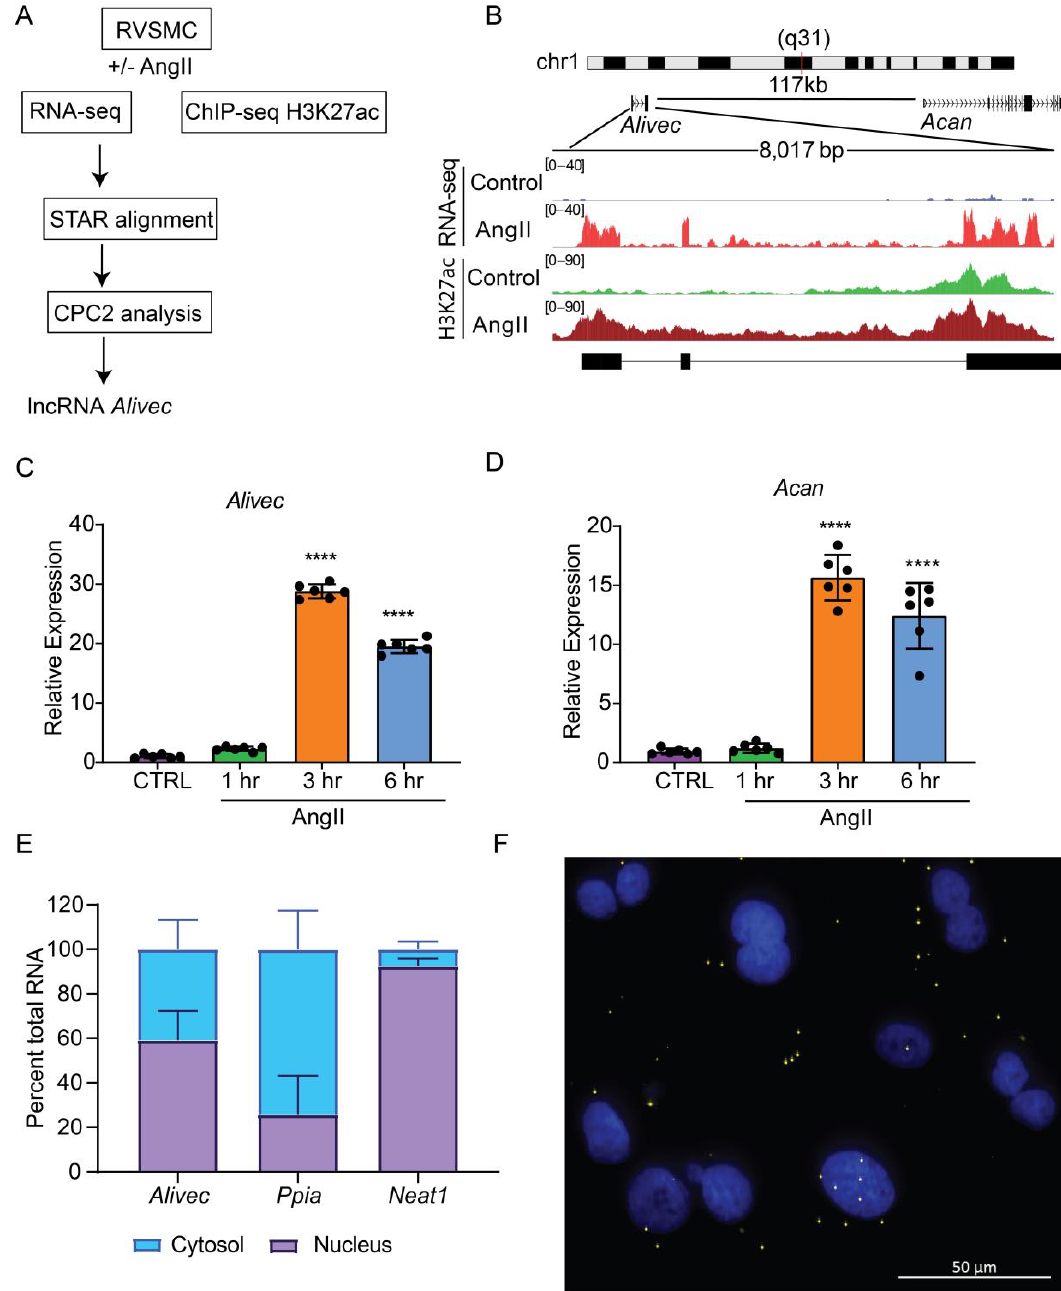
Figure 1. Alivec is an AngII-induced enhancer-associated lncRNA adjacent to chondrogenic gene Acan in RVSMCs. ( A ) Schematic diagram depicting RNA-seq and H3K27ac ChIP-seq alignment pipeline for the identification of lncRNA Alivec (AngII-induced lncRNA in vascular smooth muscle cells eliciting chondrogenic phenotype) exons, overlapping H3 lysine 27 acetylation (H3K27ac) enrichment and Alivec ’s coding potential, which was determined using the software CPC2 (coding potential calculator 2). ( B ) Schematic showing genomic organization of Alivec and the neighboring gene Acan in the rat genome. Integrative Genomics Viewer (IGV) tracks showing Alivec locus with representative RNA-seq tracks (RNA-Seq) and H3K27ac ChIP-seq tracks (H3K27ac) from control- and AngII-treated RVSMCs. ( C , D ) RT-qPCR analysis of Alivec and Acan expression in RVSMCs treated ± AngII (100 nM) for the indicated time periods. Data presented as mean ± SD, n = 6 biological replicates, one-way ANOVA followed by Dunnett’s multiple comparisons test and **** p < 0.0001 vs. control untreated cells (CTRL ( E ) RT-qPCR analysis of Alivec , Ppia and Neat1 showing their relative enrichment in cytosolic and nuclear fractions of AngII-treated RVSMCs. ( F ) Subcellular localization of Alivec in AngII-treated RVSMCs, determined by RNA–FISH analysis. Alivec is shown as distinct yellow spots and nuclei are stained with DAPI (blue). Scale bar 50 µ